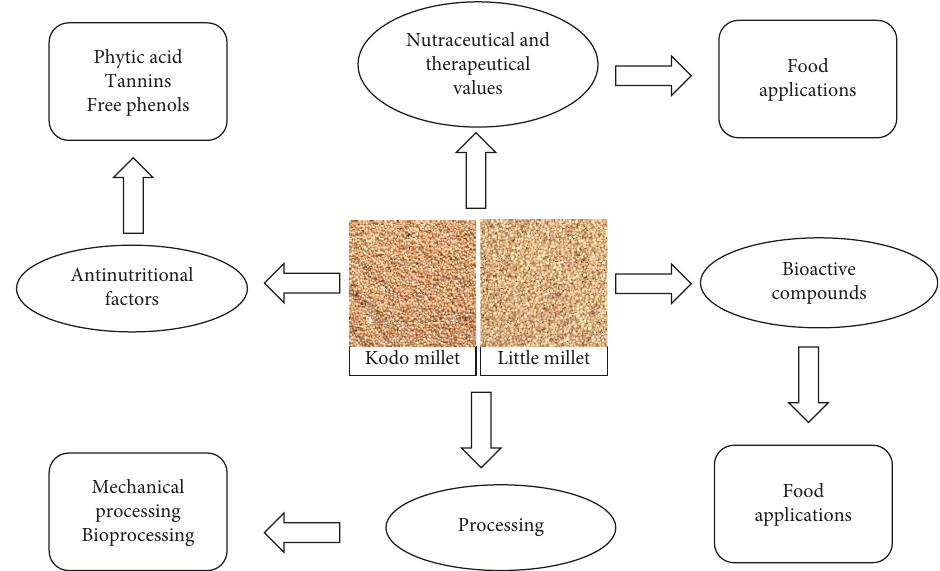
Figure 1: Applications of kodo and little